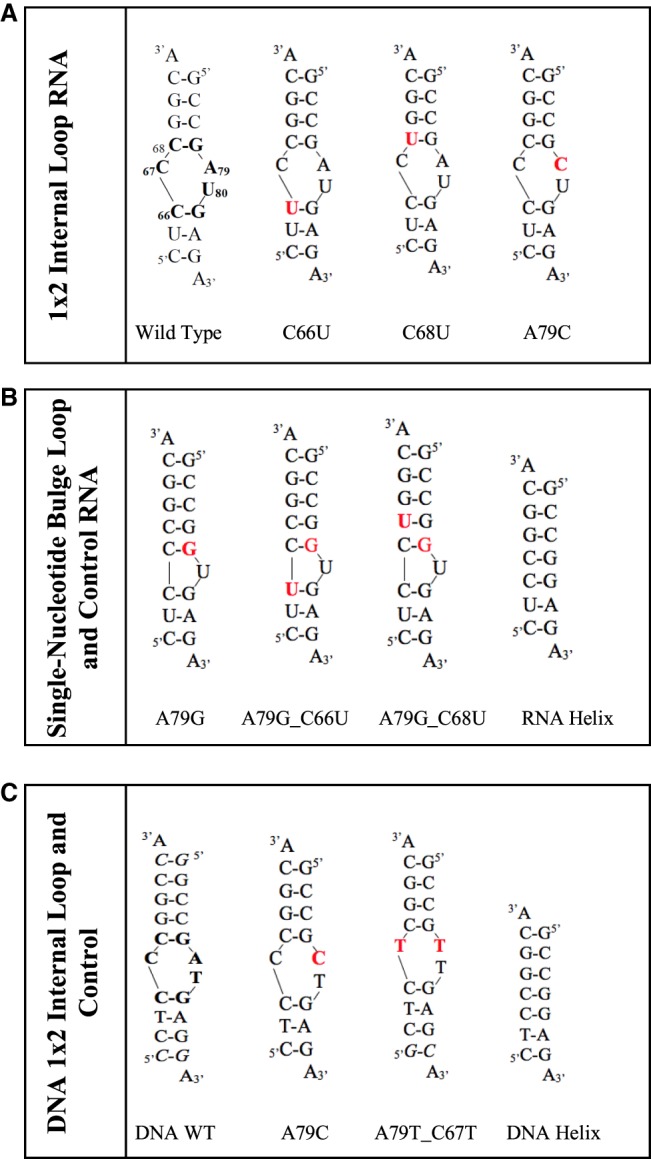
RNA and DNA constructs used in this study. (A) The RNA constructs that contain a 1 × 2 nt loop. (B) The RNA constructs that contain a single-nucleotide bulge loop and the control helix. (C) DNA constructs that contain 1 × 2 nt loop and the control helix. The additional base pairs added to the DNA constructs to increase RNA stability are shown in italics. Motif being examined is shown in bold font on the wild type; modifications to the motifs are in red.